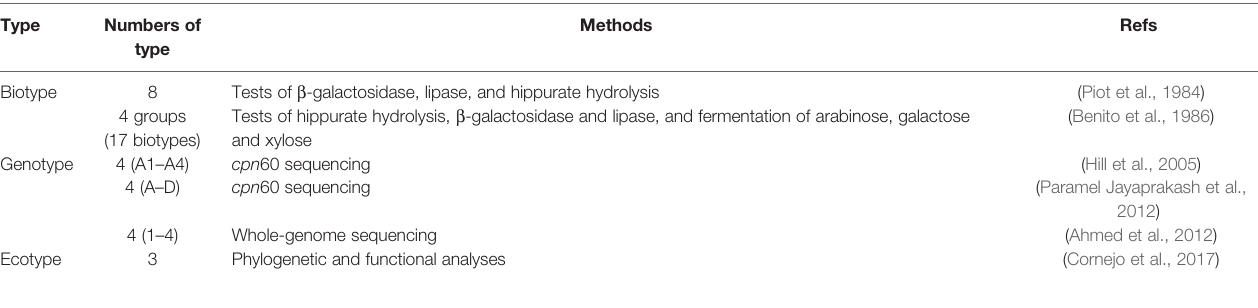
TABLE 1 | Types of G. vaginalis